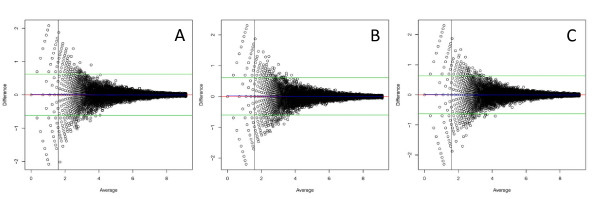
Bland-Altman plot for simulated data. The data were log transformed and the average of the two technical replicates is on the X axis and the difference between technical replicates is on the Y axis. (A) Simulated replicates 1 versus 2. (B) Simulated replicates 1 versus 3. (C) Simulated replicates 2 versus 3. Green lines are the average of all differences +/- 1.96 (standard deviation of the differences). The red line is drawn at zero. The blue line is a lowess fit.